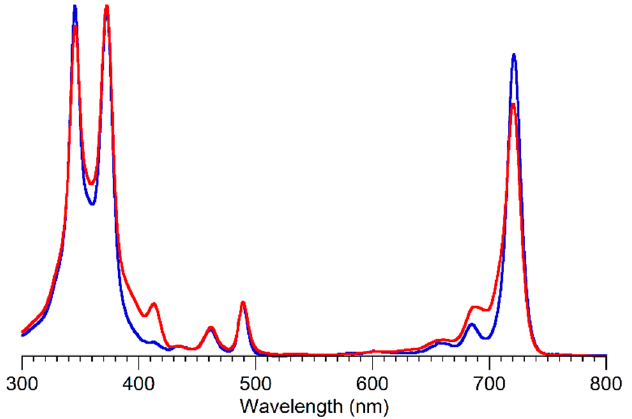
Figure 2. Absorption spectrum of BC-1 (blue line) and BC-2 (red line) in CH 2 Cl 2 at room temperature (normalized in the B band).